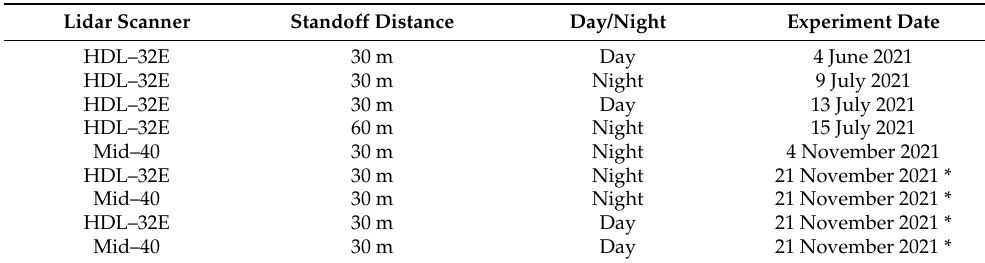
Table 3. Experiment List and